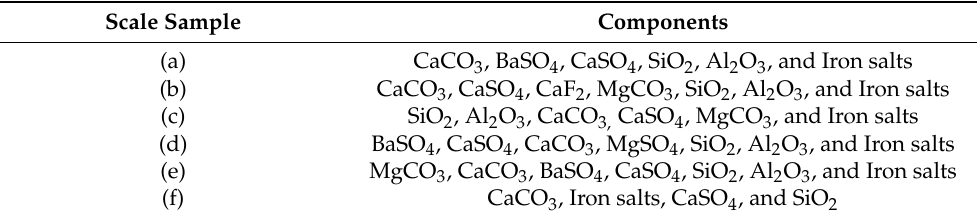
Table 1. The speculated compositions of each